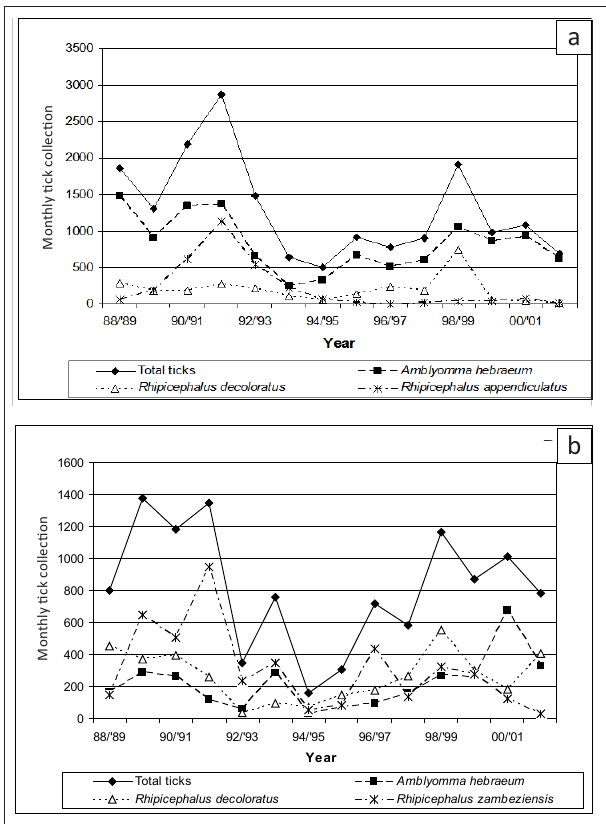
FIGURE 2: Mean monthly collections of the total number of ticks and the three major tick species by year at a) Nhlowa Road and b) Skukuza.